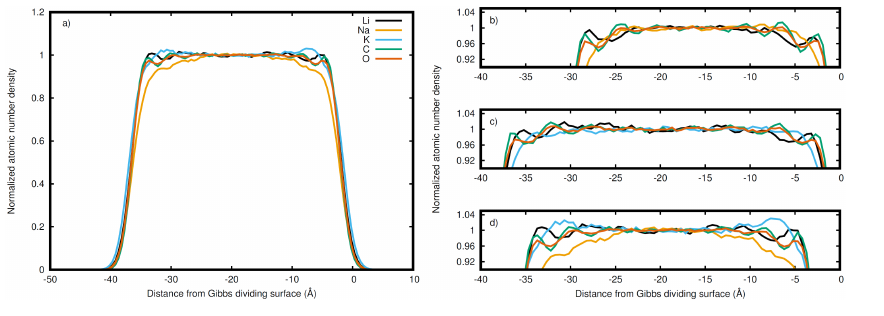
Figure 3 Normalized densities with respect to the right Gibbs dividing surface. Li (black), Na (orange), K (blue), C (green), and O (red) in the (A) entire LiNaKCO 3 system and detailed views of the liquid re- gion for (B) LiNaCO 3 , (C) LiKCO 3 , and (D) LiNaKCO 3 are shown. For each system, the right Gibbs di- viding surface is positioned at 0 Å. The peaks and valleys are indicative of the atomic structuring near the surface.